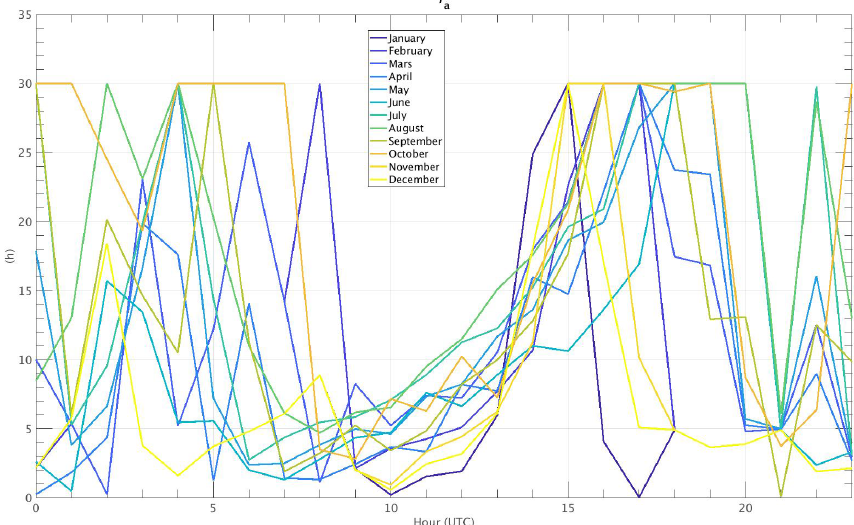
Figure A3. Mean-hourly τ a value for each month of the